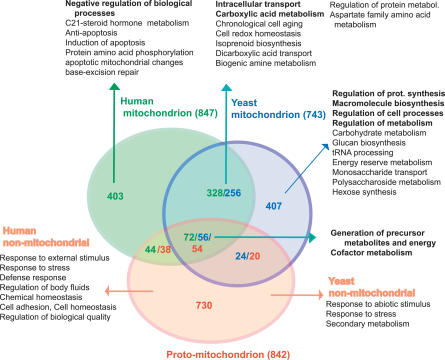
Venn Diagram Representing the Overlap of the Three Considered ProteomesThe human mitochondrial proteome (green) [25], the yeast mitochondrial proteome (blue) [24], and the reconstructed proto-mitochondrial proteome (brown). For each proteome, the number of proteins in each fraction is indicated. The numbers of proteins in a single fraction vary because there are varying numbers of (in-)paralogs between the species within the same OG. Arrows from each fraction point to lists of biological process GO terms that are significantly enriched (bold) or specific to that fraction (see Materials and Methods). No significantly over-represented terms were found in the proto-mitochondrial–derived fractions of the mitochondrial proteome, likely due to the fact that most of their pathways (e.g., electron transport chain) also have components of eukaryotic origin.